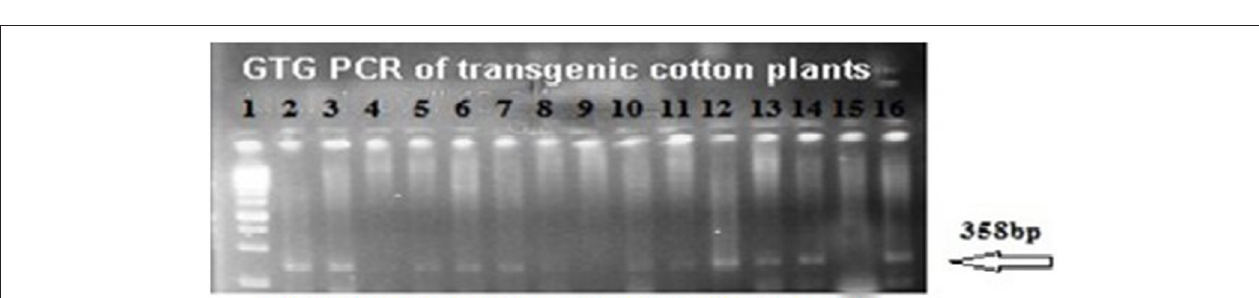
FIGURE 4 | PCR amplification of transgenic cotton plants of VH 289 for Cry2A. Lane 1 represents 1kb ladder; Lane 2 to 14 represent the transgenic cotton plants with Cry2Ac gene; Lane 15 shows negative control; Lane 16 is the positive control cotton plants.